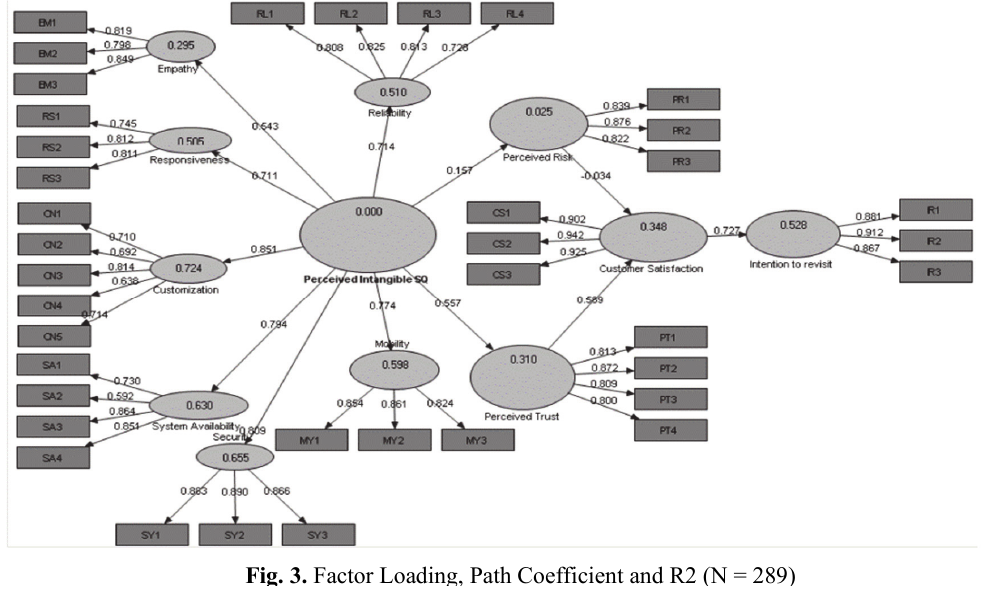
Fig. 3. Factor Loading, Path Coefficient and R2 (N =